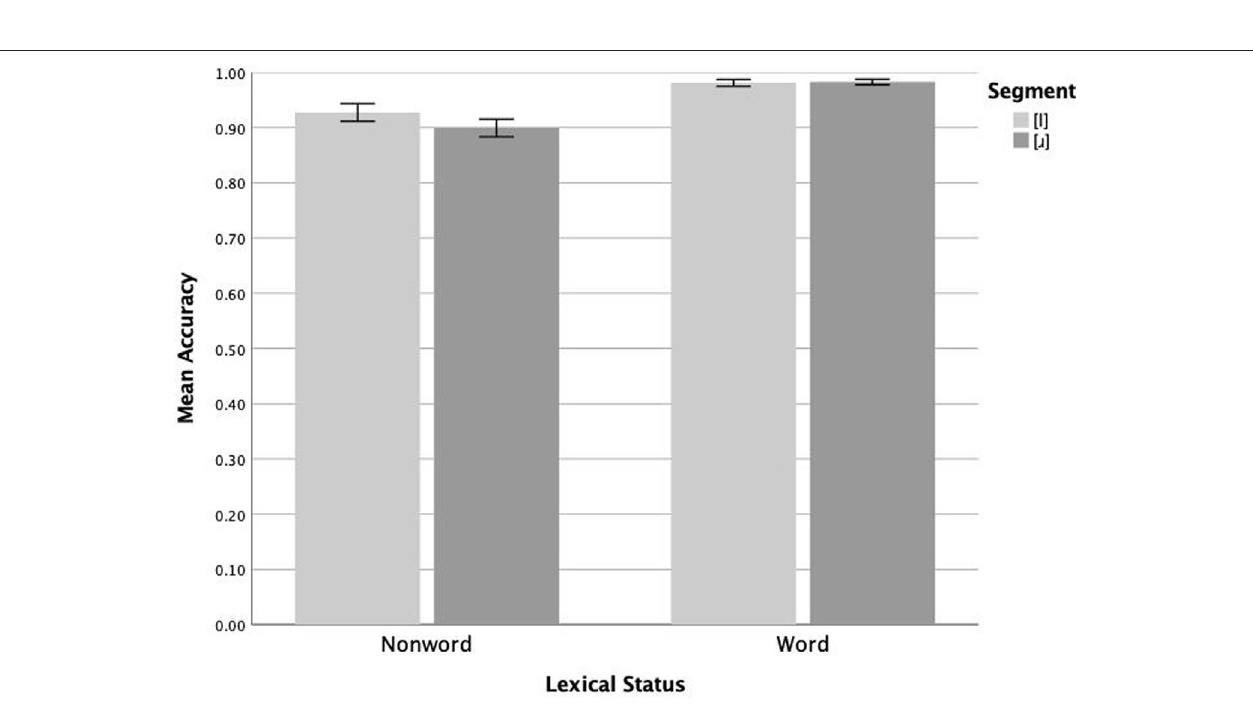
Frontiers in Communication |